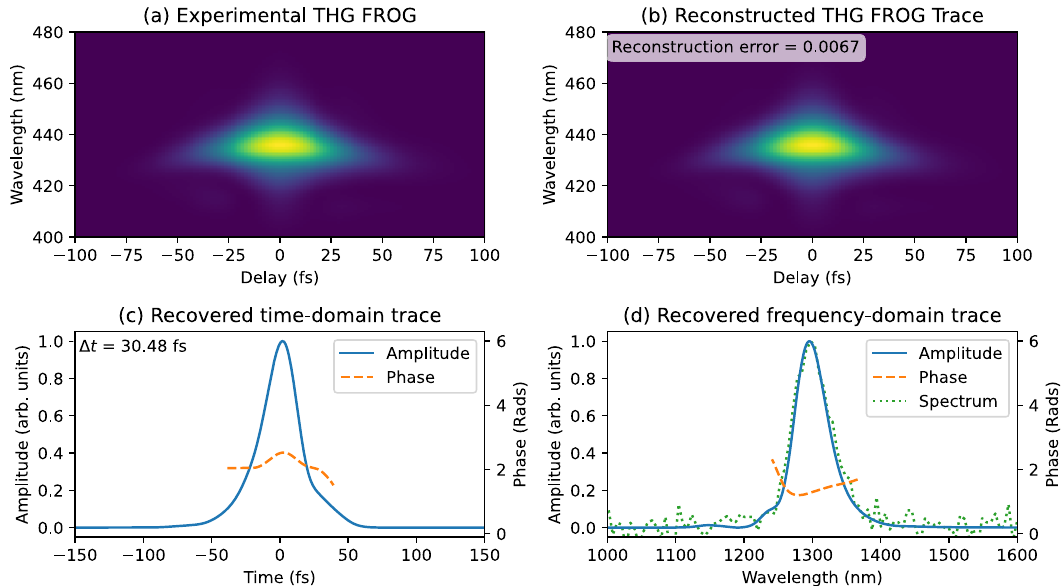
Fig. 4 TH-FROG measurements. a TH FROG traces experimentally acquired from our AZO fi lm. b Reconstructed FROG traces generated by the FROG retrieval algorithm (Retrieval error of 0.0067). c Recovered temporal amplitude (solid blue line) and phase (dashed orange line) pro fi les (FWHM time duration 4 t ¼ 30 : 48 fs ). d Recovered spectral amplitude (solid blue line) and phase (dashed orange line) pro fi les. This plot also reports the experimentally acquired input spectra (dotted green line) for